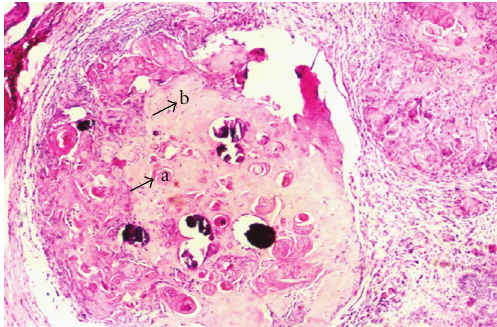
Figure 4: Ghost cells (a) and surrounding dentinoid-like material (b) [Hemataoxylin and Eosin, ×